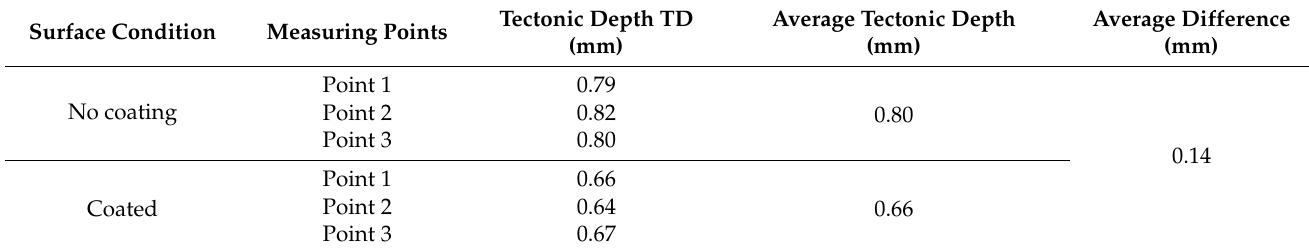
Table 10. Texture depth of asphalt